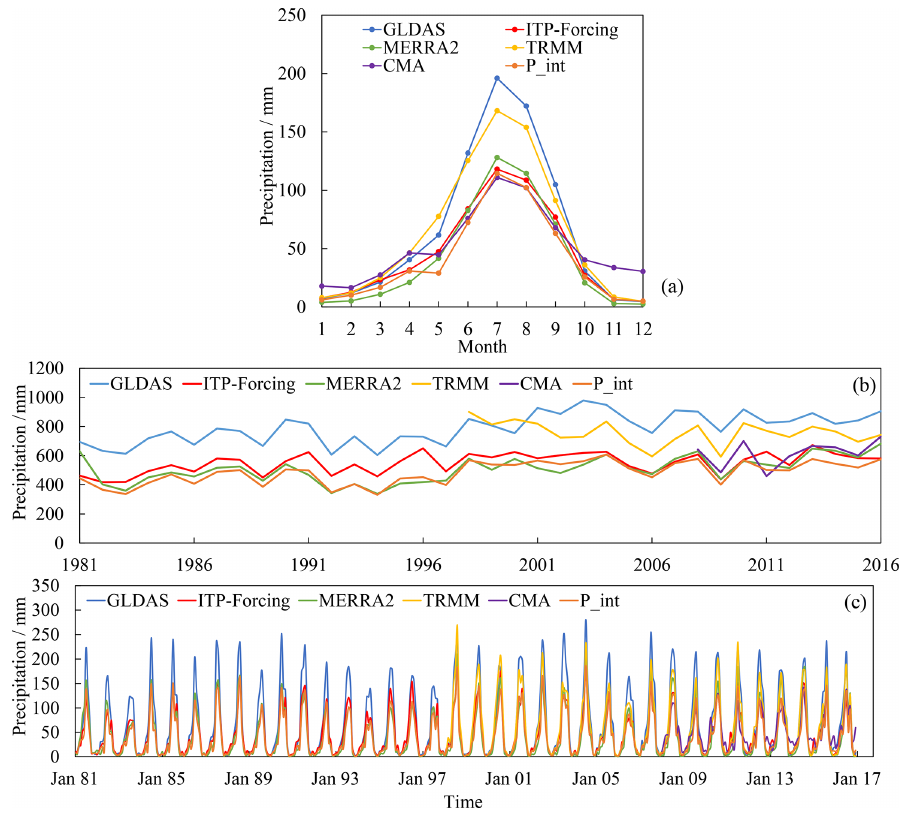
Figure 5. Variations in basin-averaged precipitation from multiyear monthly mean values (a) , annual values (b) , and monthly values (c) for the different